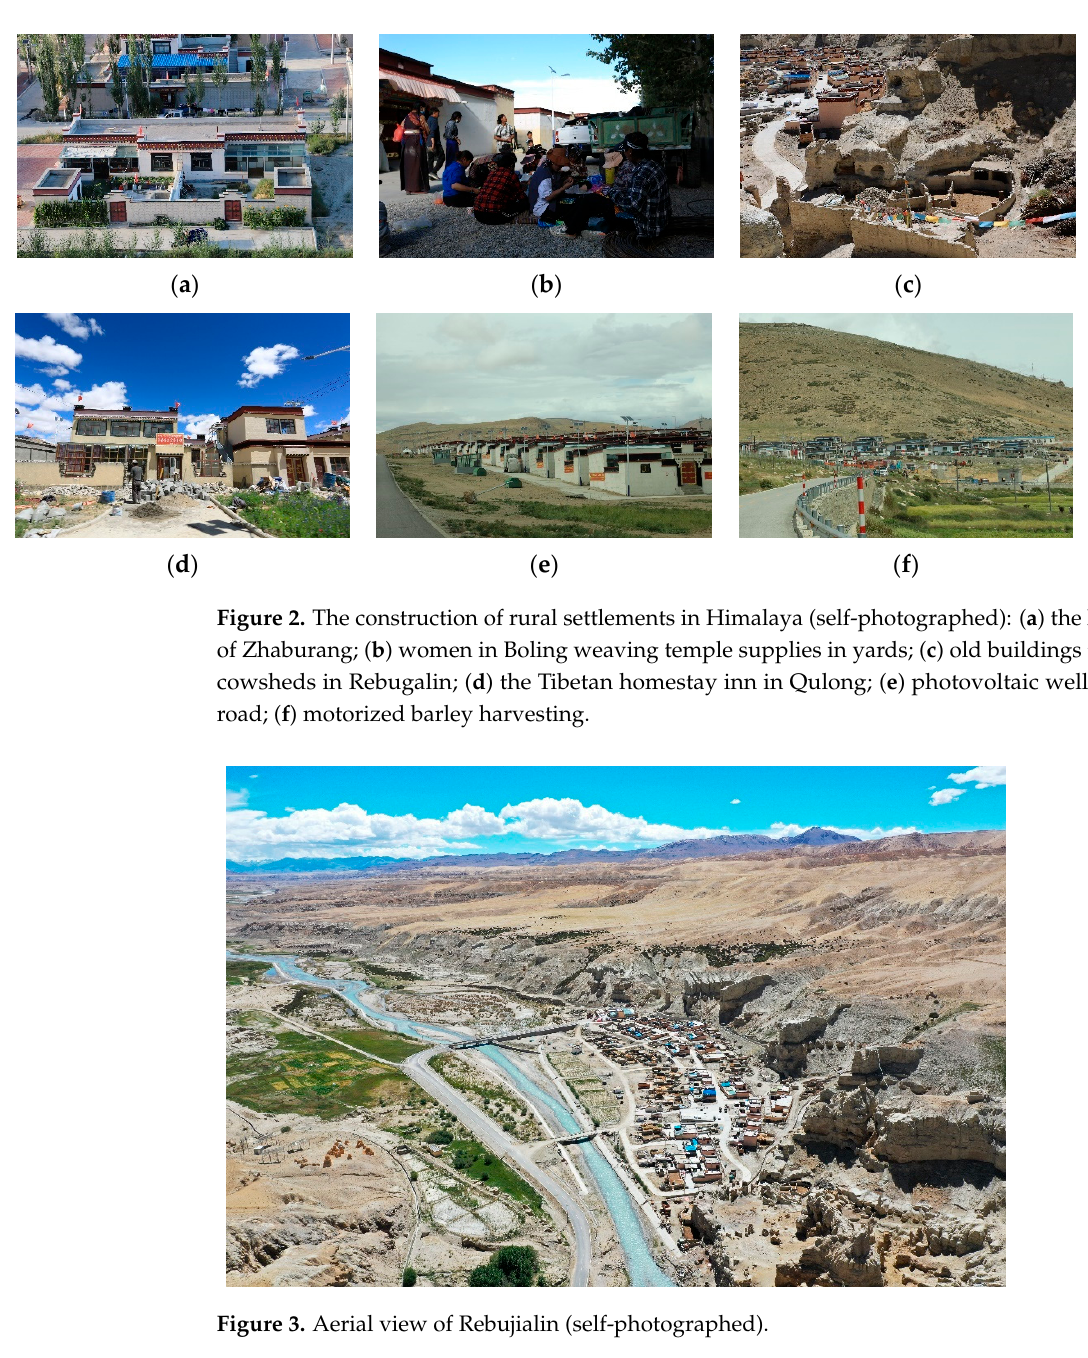
Figure 1. Sample distribution of 15 rural settlements in Zhada County.